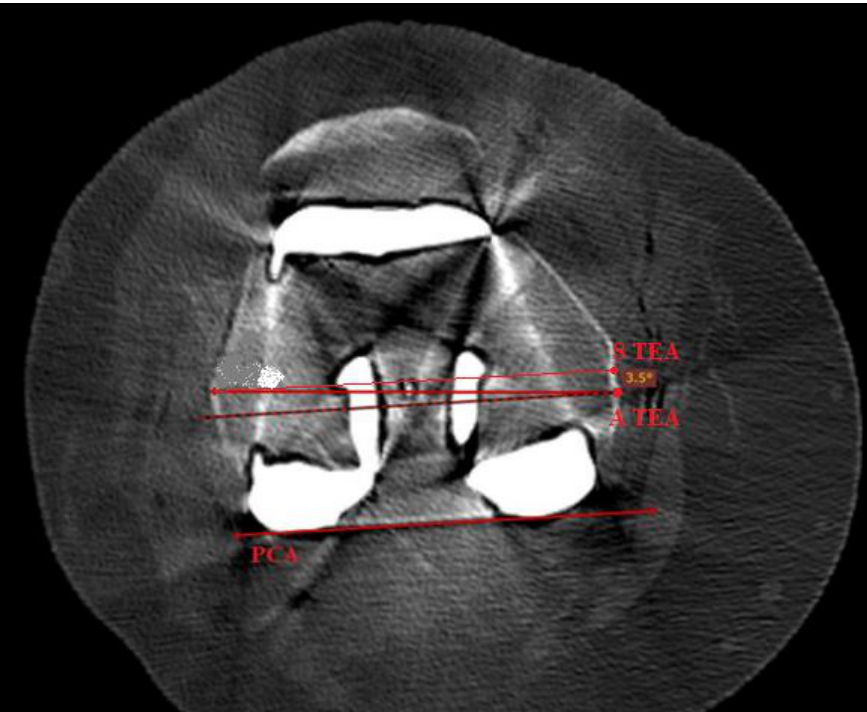
Figure 3. Postoperative TKA CT scan of one of the patients analyzed in the study. It reveals the graphical representation of S TEA and PCA lines, utilized and described in the study methods.